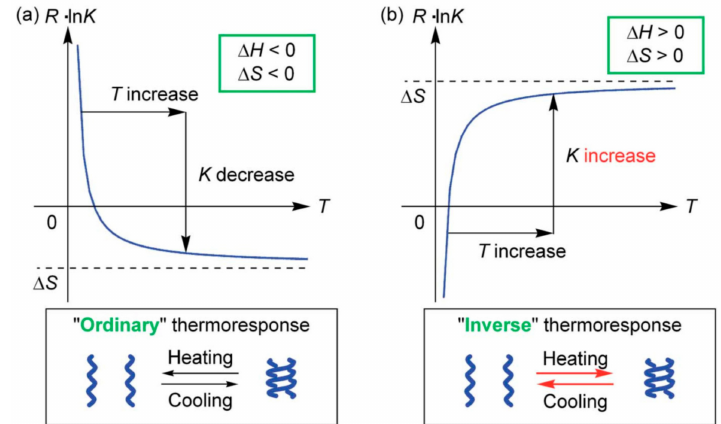
Figure 14. Ordinary thermo responses ( a ) and inverse thermo responses ( b ) shown by the plots of RT ln K against association constant K , in which the relation is shown by free energy, ∆ G = − RT ln K = ∆ H − T ∆ S